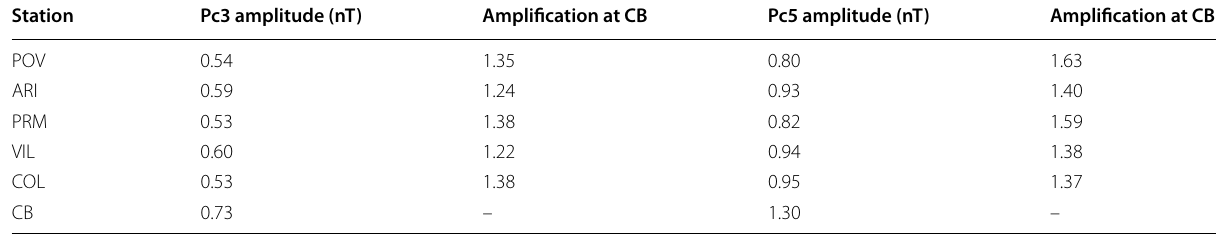
Amplification at CB is the ratio of the amplitude at the CB station to that at the other stations